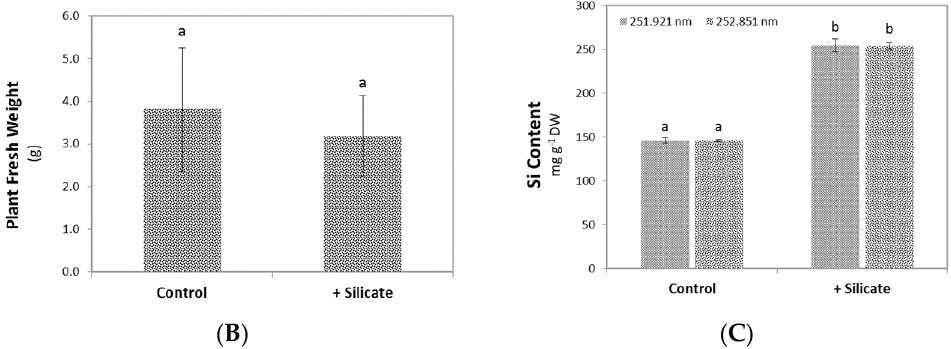
Figure 1. ( A ): ‘Joker’ plants grown in vitro without (upper panel) and with (lower panel) silicate-supplemented fertiga- tion; ( B ): Fresh weight; and ( C ): silicon content of the plants at the end of the experiment. Values are means ± SD and different letters above the bars indicate significant difference between the treatments (Tukey post hoc: p < 0.05); n = 20.